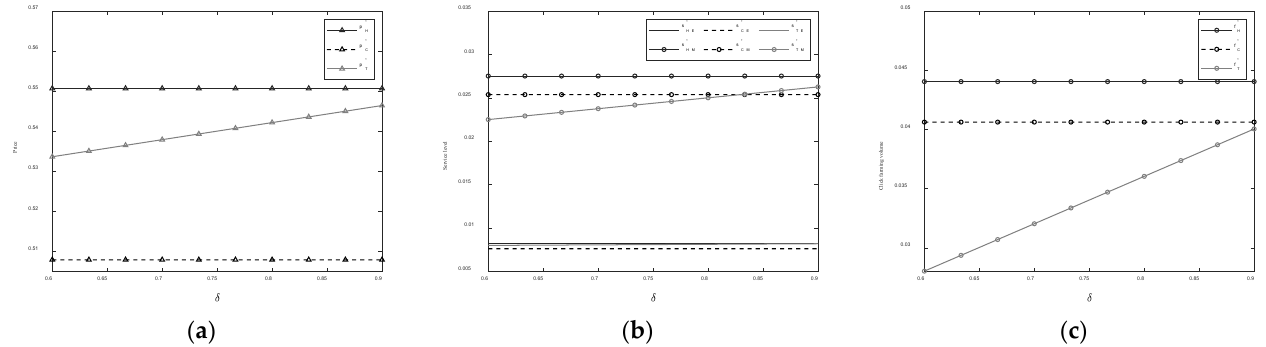
Figure 6. Influence of brand’s return-freight insurance purchasing ratio on price ( a ), service level ( b ) and click farming volume ( c ) respectively.